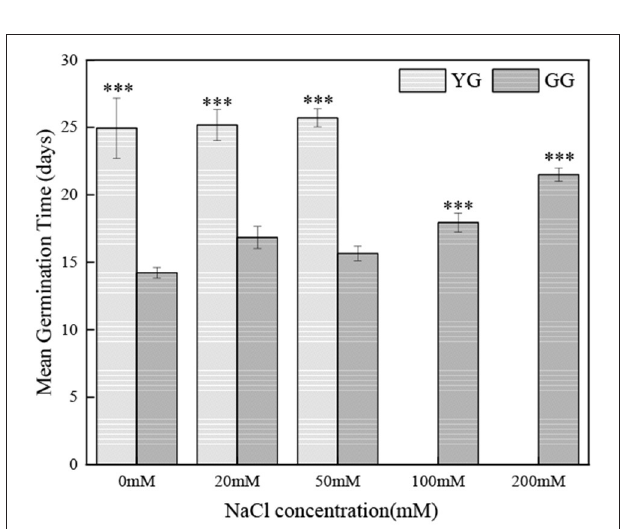
FIGURE 4 | Effects of salt stress on the seed total germination of different L. chinensis ecotypes, incubated at 28/16 ◦ C (12 h light/12h dark) for 30 d. There were four replicates for each treatment. Values are means ± standard error (SE). * , ** , *** Indicate significant differences between the different ecotypes under the same NaCl concentration at 0.05, 0.01, and 0.001 level respectively, and “ns” indicates no significant differences.